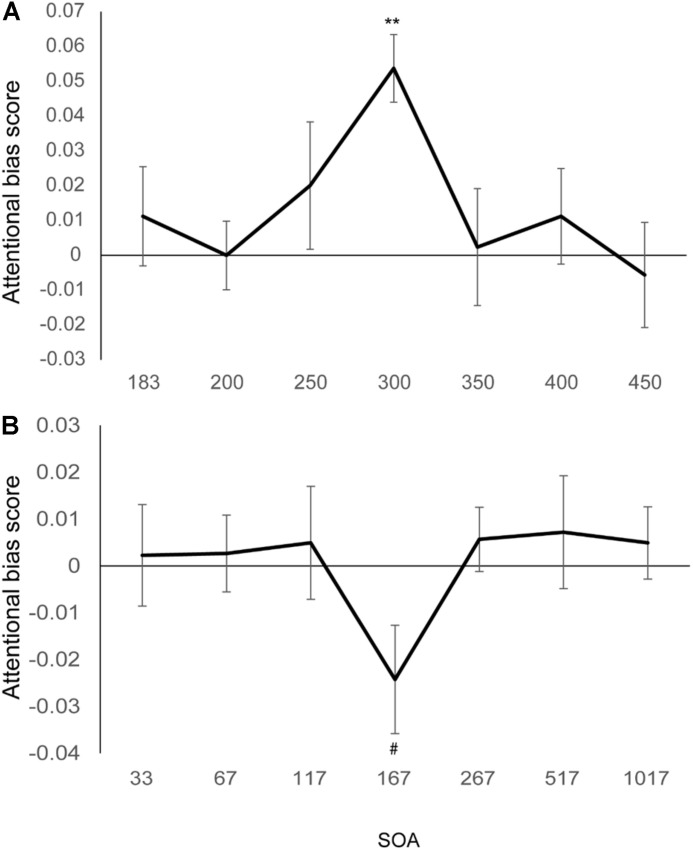
Results of Experiments 3 and 4. (A) The emotional attention effect of Experiment 3 by comparing accuracy in the valid cue with that in the invalid cue condition. The improvement was found at the SOA of 300 ms. (B) The emotional attention effect of Experiment 4. No improvement but a trend of interference was found at the SOA of 167 ms. **p < 0.01, Bonferroni corrected; #p < 0.05, uncorrected. Error bars represent standard error of the mean.